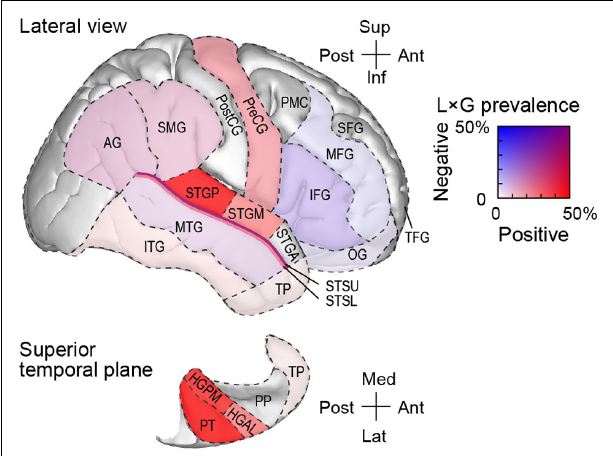
FIGURE 9 | Schematic of regional distribution of L × G interactions in the awake state. ROIs are color-coded according to prevalence of positive and negative interactions. For ROIs where only a single site exhibited a significant interaction (PP, STGA, PostCG, and PMC), prevalence estimates are not shown. See text and Table 2 for details. AG, angular gyrus; HGAL, anterolateral Heschl’s gyrus; HGPM, posteromedial Heschl’s gyrus; IFG, inferior frontal gyrus; L × G, local-by-global; MFG, middle frontal gyrus; MTG, middle temporal gyrus; OG, orbital gyrus; PMC, premotor cortex; PP, planum polare; PreCG, precentral gyrus; PostCG, postcentral gyrus; PT, planum temporale; ROI, region of interest; SFG, superior frontal gyrus; SMG, supramarginal gyrus; STSL, STSU, lower and upper bank of the superior temporal sulcus, respectively; STGA, STGM, STGP, posterior, middle, and anterior superior temporal gyrus, respectively; TFG, transverse frontopolar gyrus; TP, temporal